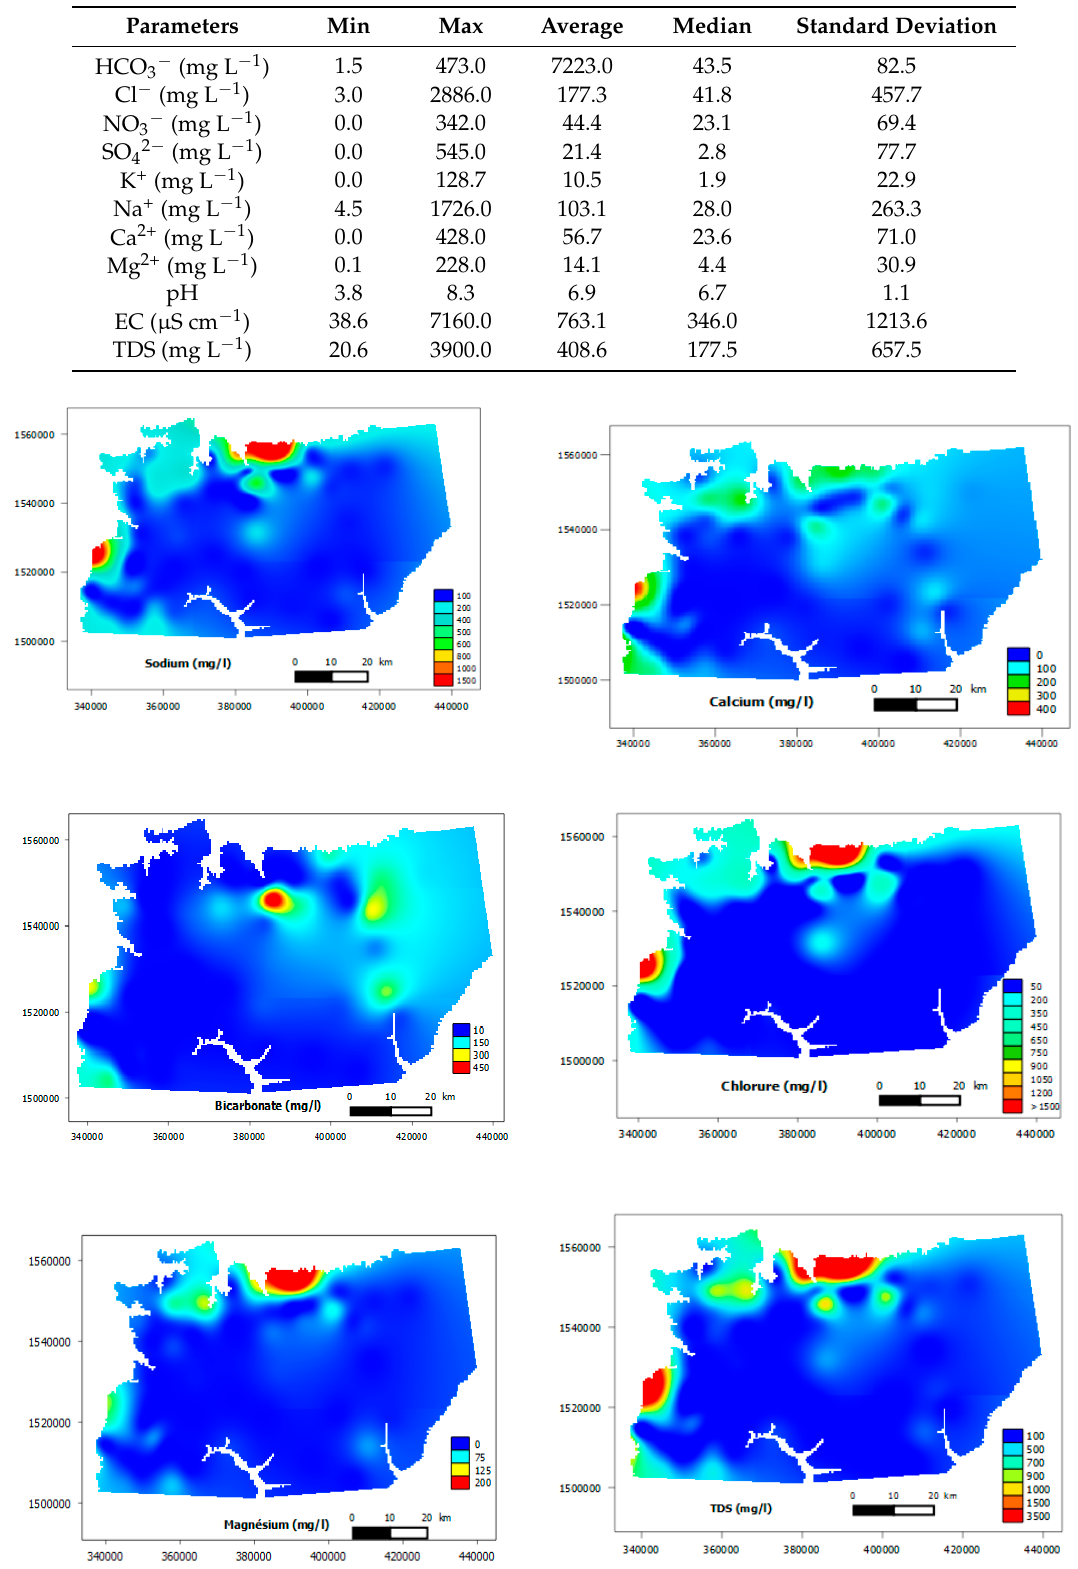
Figure 4. Distribution of the main elements contents (mg/L) and TDS (mg/L) in the groundwater.